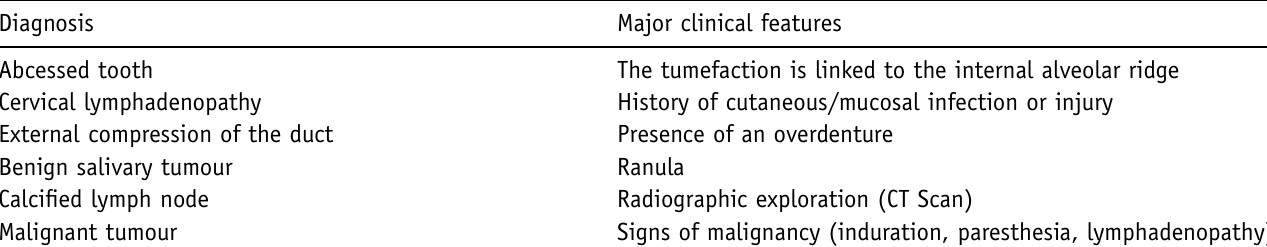
Table I. Differential diagnosis of submandibular sialolithiasis.